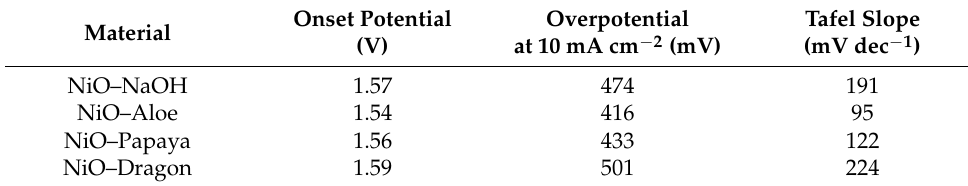
Figure 6. ( a ) Polarization curve by linear sweep voltammetry, ( b ) overpotential at 10 mA cm − 2 and ( c ) Tafel plot. Table 2. Electrocatalytic parameters of NiO x